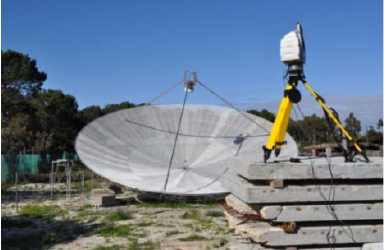
Figure 1: Satellite dish and the setup of the scanner to capture the